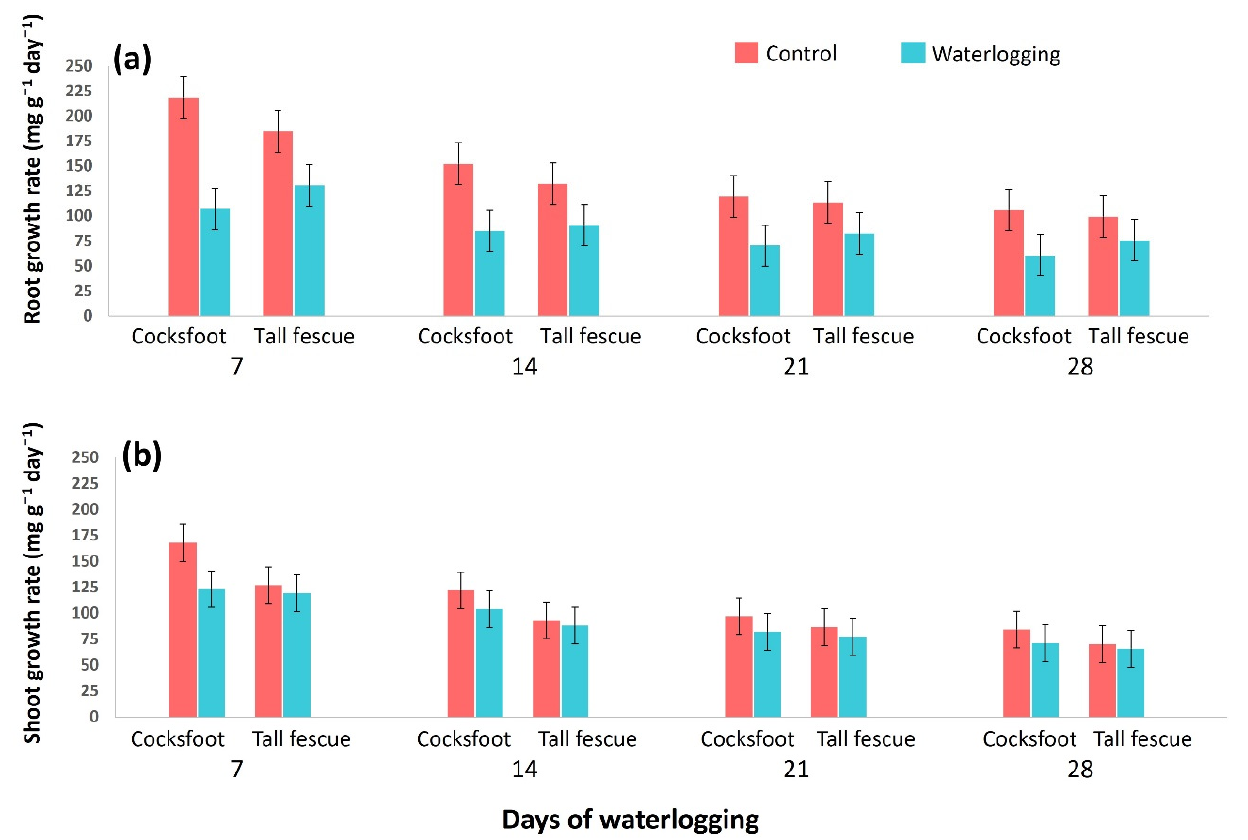
Figure 5. Root ( a ) and shoot ( b ) growth rate of tall fescue and cocksfoot at different stages of treatment under both control and waterlogging conditions. Values given are least squares means of four replicates and error bars indicate 95% confidence intervals of the least squares means.